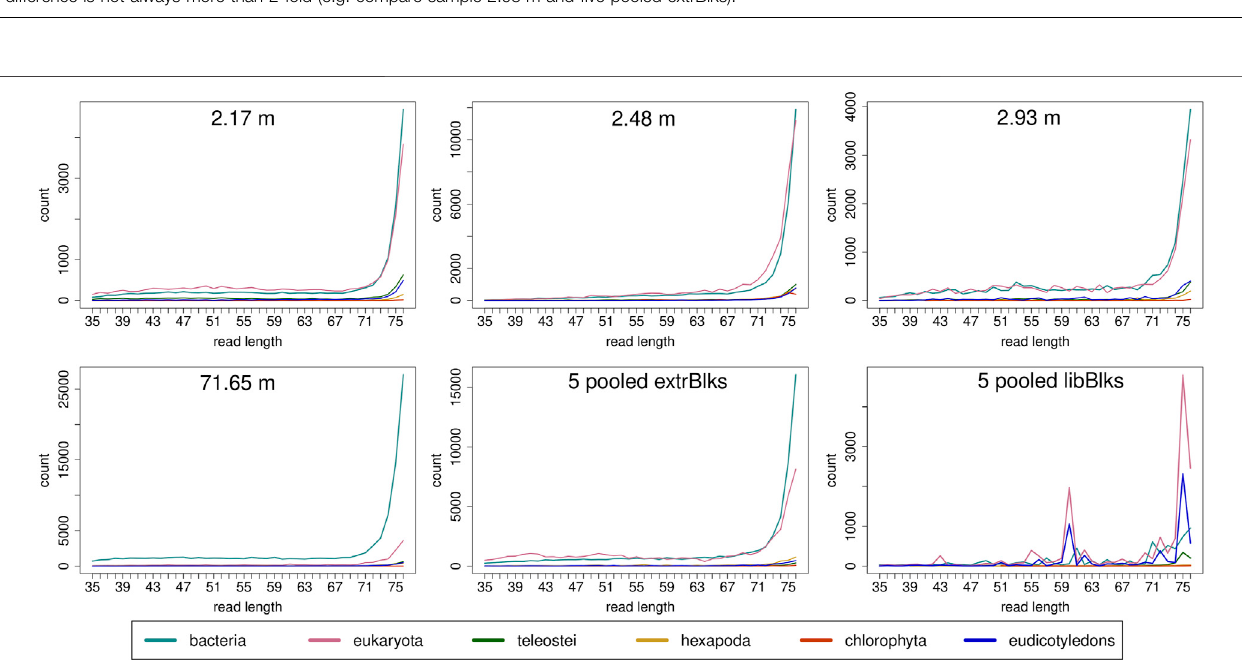
FIGURE 4 | Read length distribution of all reads after duplicate removal for second round capture data. Longer reads ( > 70 bp) dominate all samples. The pooled blanks(oneformockextractions “ 5pooledextrBlks ” andoneformocklibrarypreparations “ 5pooledlibBlks ” )displaylowerreadnumberscomparedtosamples,yetthe difference is not always more than 2-fold (e.g. compare sample 2.93 m and fi ve pooled extrBlks).